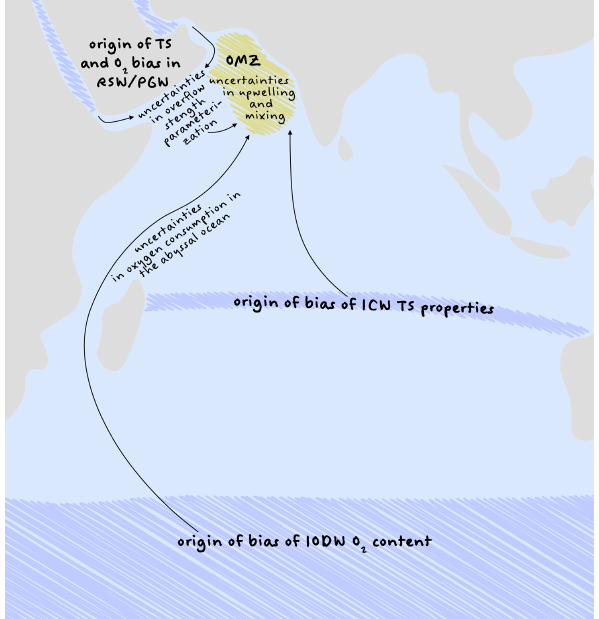
Figure 7. Overview sketch of the analysed origins of model–data misfits in oxygen in CMIP5 models. The blue shaded areas mark the origins of the water masses and their related biases in the models. The arrows sketch the way into the OMZ and uncertainties on the way. The yellow shaded area sketches the OMZ in the Arabian